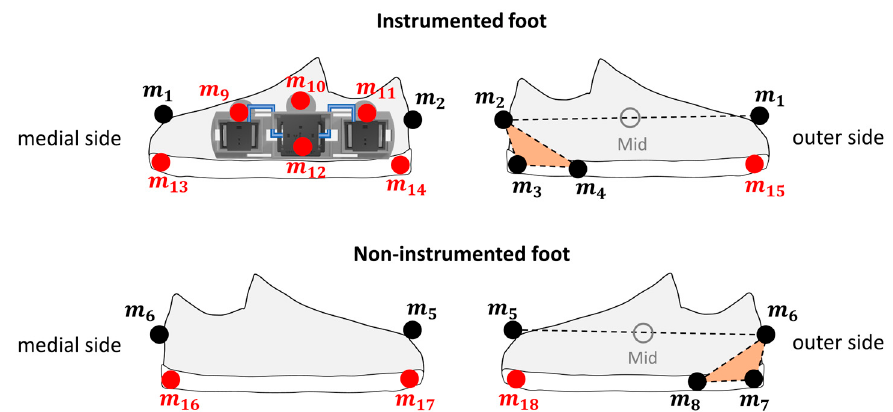
Figure 10. Positions of the 18 retro-reflective markers attached for validation purposes. The right foot was instrumented with the wearable system. The virtual markers in red ( m 9 – m 18 ) were used only during the initial standing acquisition for calibration purposes. Mid was the midpoint between heel and toe markers ( m 1 – m 2 for instrumented foot; m 5 – m 6 for non-instrumented foot). The marker clusters highlighted in orange (m 2 –m 4 for instrumented foot; m 6 -m 8 for non-instrumented foot) defined foot coordinate systems.